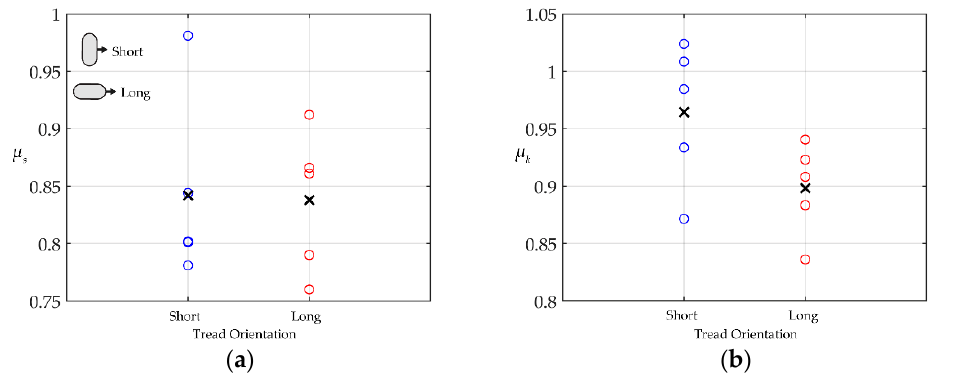
Figure 6. ( a ) The static CoF readings for the step test; ( b ) The dynamic CoF readings for the slide